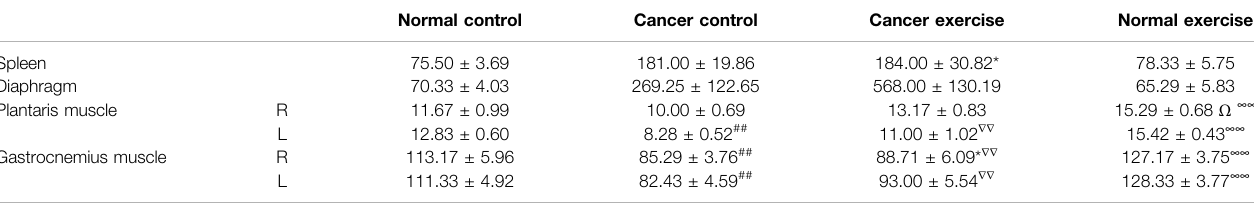
TABLE 1 | Tissue weight data.